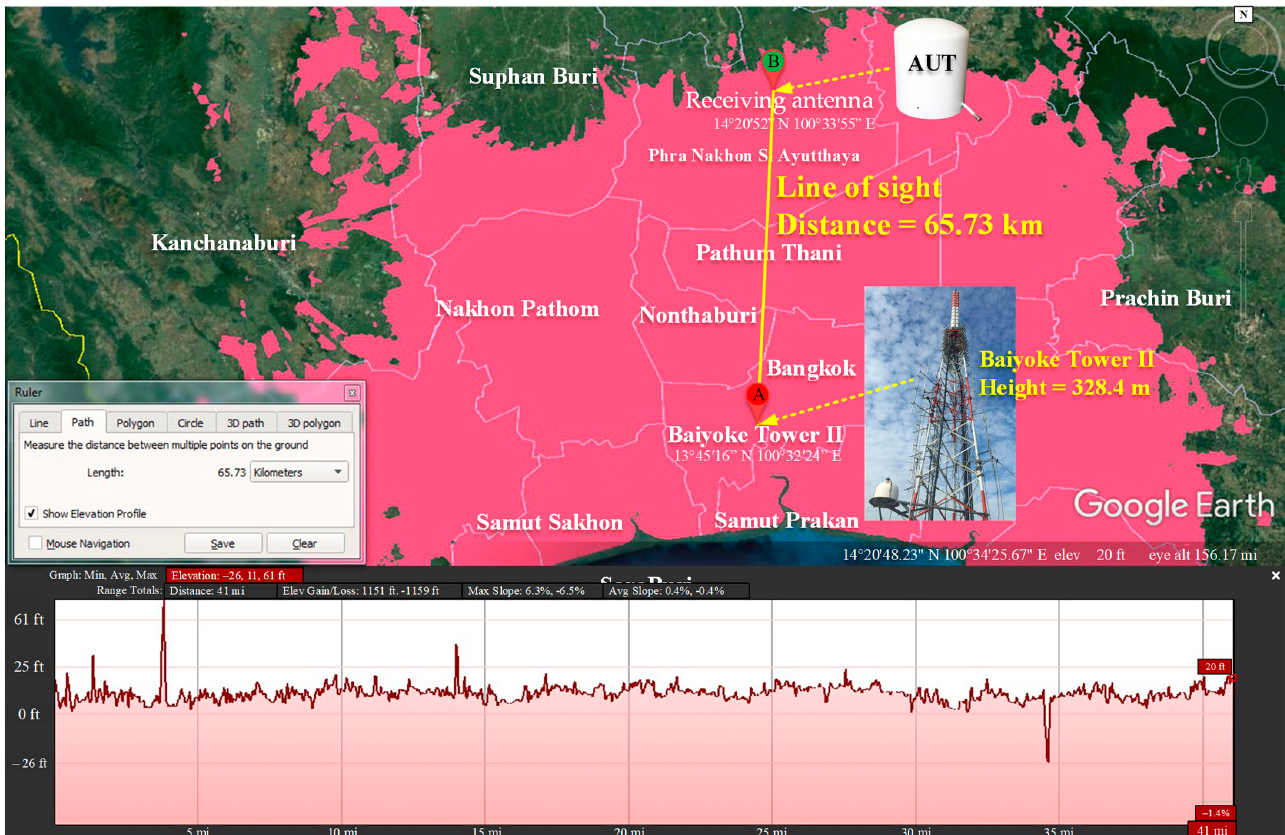
Figure 20. Distance between the transmitting and receiving antennas without obstructions (line of sight).